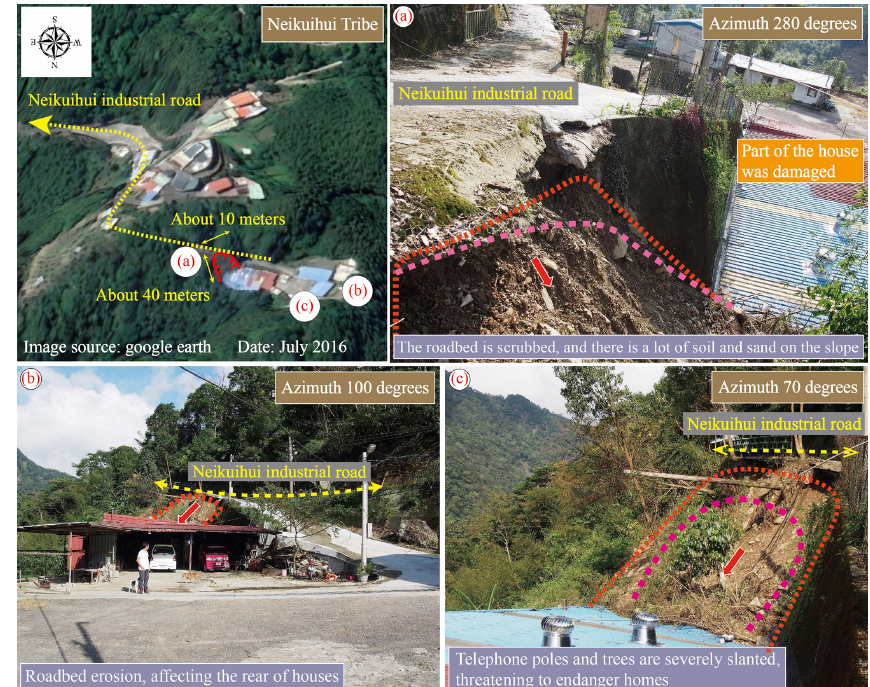
Figure 14. Historical disaster event at the No. 11 slope unit during Typhoon Meiji 2016 (picture source: Water and Soil Conservation Bureau, 2016; aerial: ESRI ArcGIS